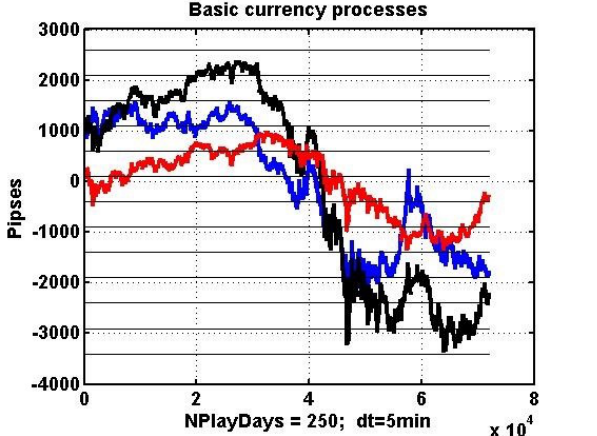
Figure 1. Change dynamics of EURUSD, EURJPY, and USDJPY during 250 observation